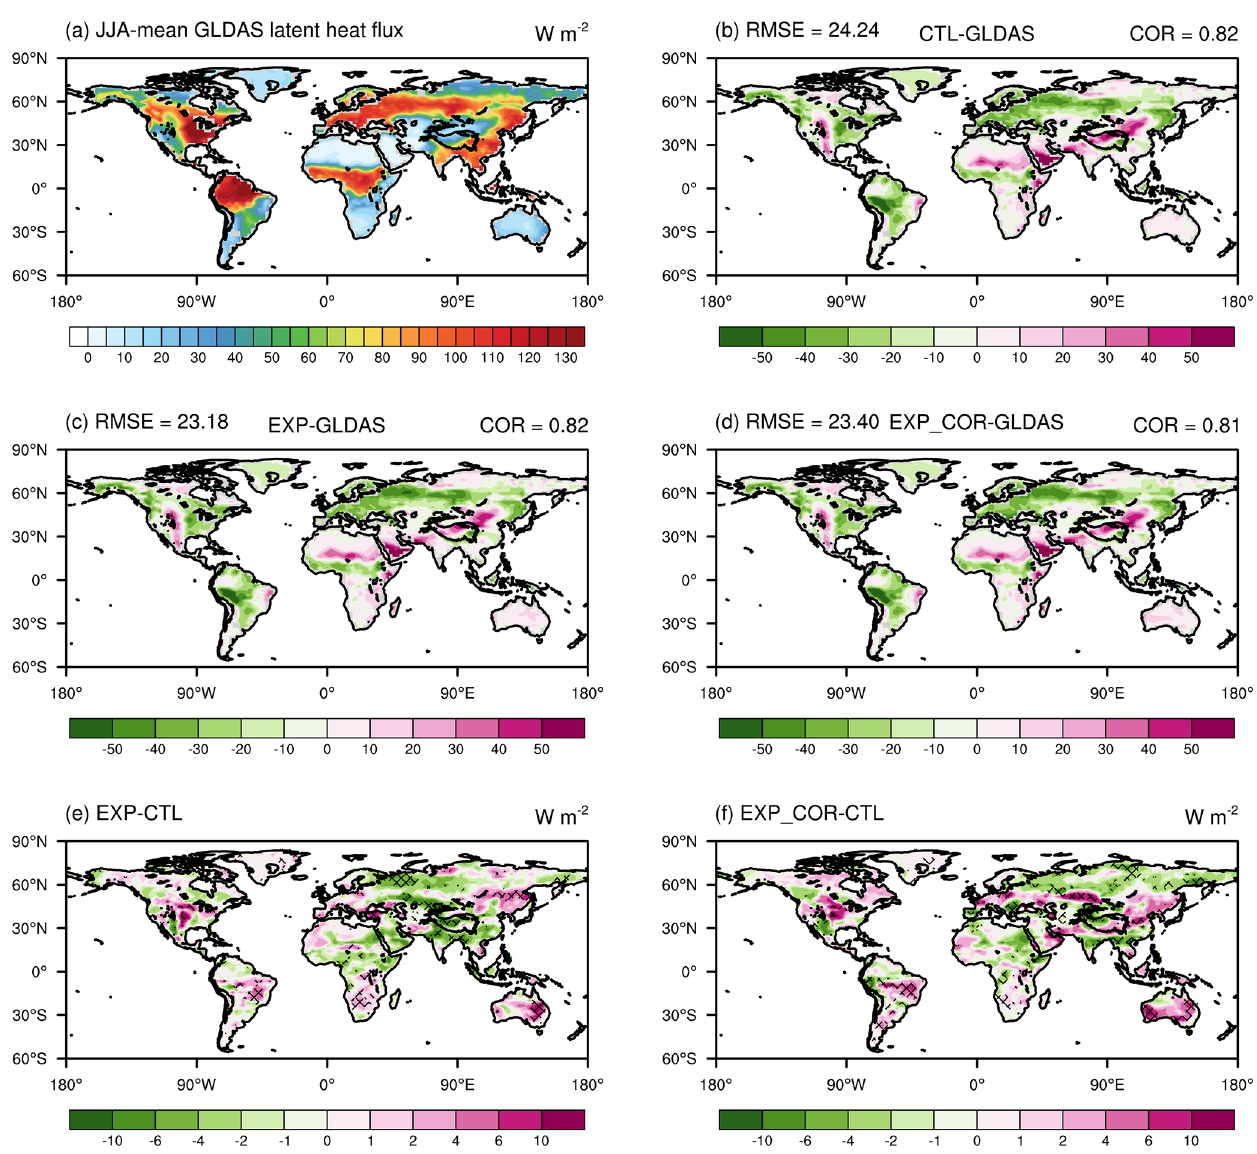
Figure 7. Spatial distributions of the JJA-mean latent heat flux in (a) GLDAS (upward positive); the biases of (b) CTL, (c) EXP, and (d) EXP_COR with respect to GLDAS; and the differences between (e) EXP and CTL and between (f) EXP_COR and CTL. The crossed areas are significant at the 95% level. The averaged spatial COR and RMSE values for the three simulations are given in (b) – (d)